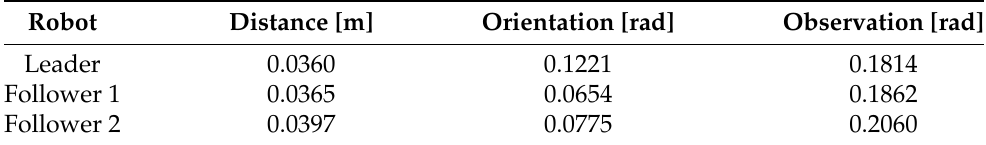
Table 3. RMS errors of distance, orientation and observed orientation of the robots in the lemniscate trajectory